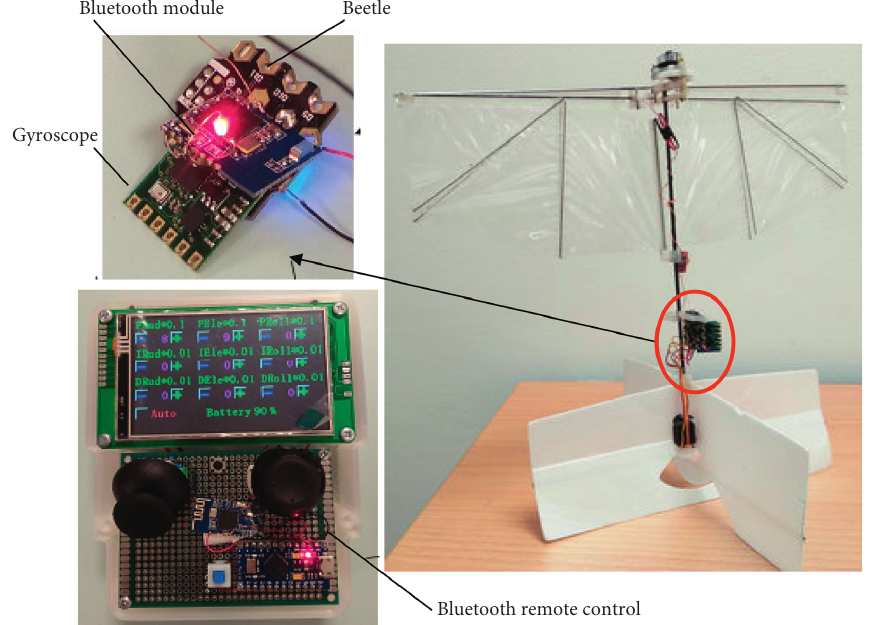
Figure 12: The ornithopter, control system, and remote control prototype.